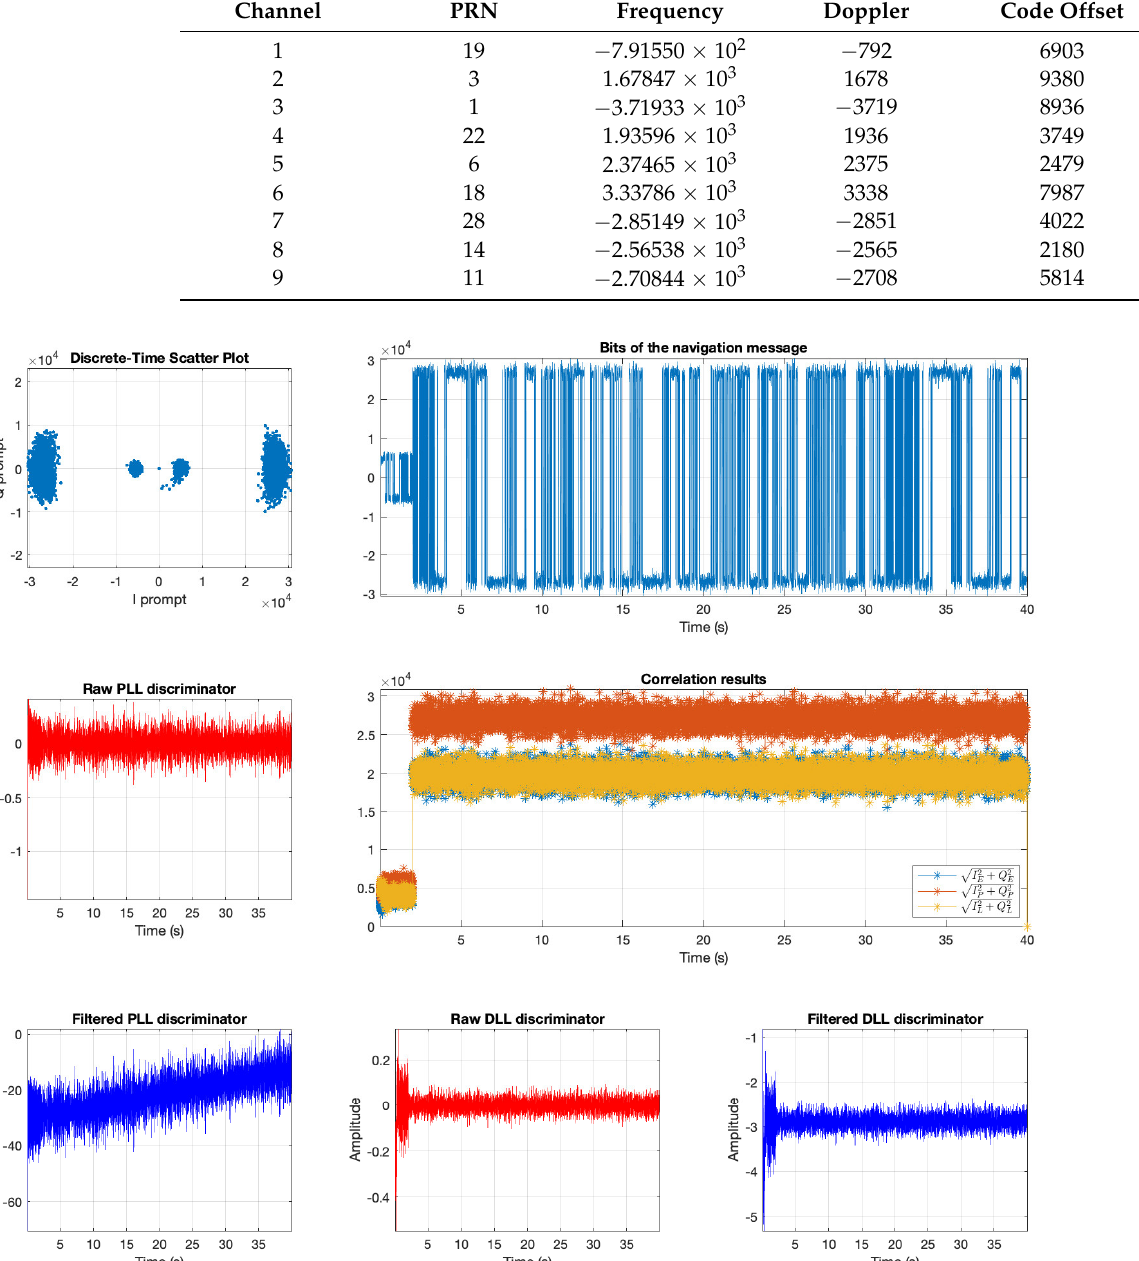
Figure 13. Tracking results of PRN 19.